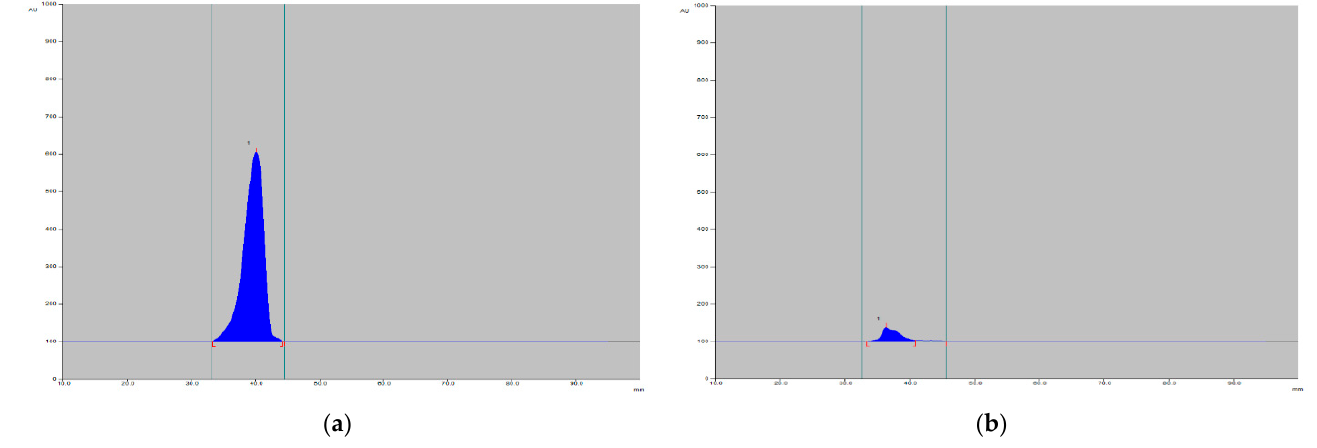
Figure 4. Example densitograms registered for a model mixture with the composition ‘CEF, EST, KET’ after ( a ) 0 min, ( b ) 30 min, of UV irradiation.